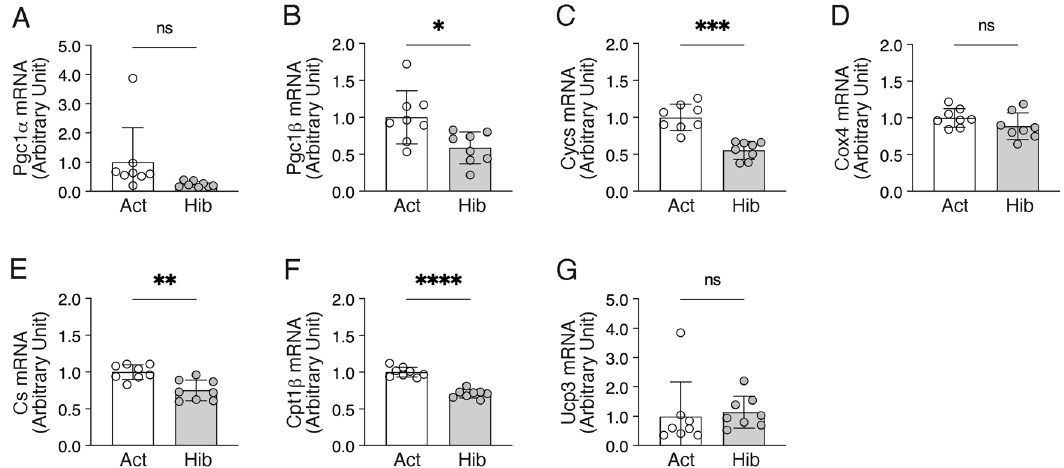
Figure 6. Expression of the mitochondria-related genes in bear skeletal muscles during hibernation . Gene expression levels of the peroxisome proliferator-activated receptor gamma coactivator 1 (Pgc1)-alpha ( A ), Pgc1b ( B ), cytochrome c ( C ), cytochrome c oxidase 4 ( D ), citrate synthase ( E ), carnitine palmitoyltransferase 1b ( F ), and uncoupling protein 3 ( G ) were quantified by real-time PCR. Ribosomal protein L26 was used as an internal control for the 2 –ΔΔCT method. n = 8 in each group. Data are expressed as mean ± standard deviation (SD). Significant differences: *p < 0.05, **p < 0.01, ***p < 0.001, ****p < 0.0001 between active versus hibernation period.